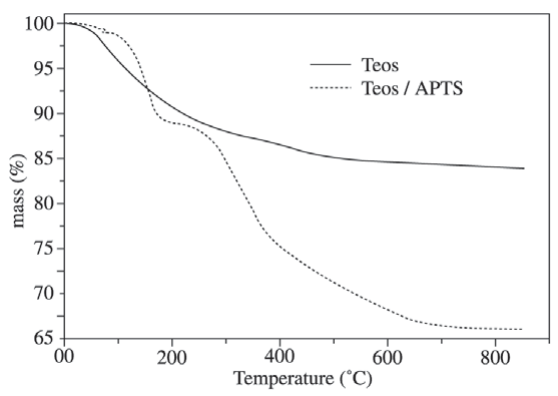
Figure 1. Thermogravimetric curve for samples used as control.